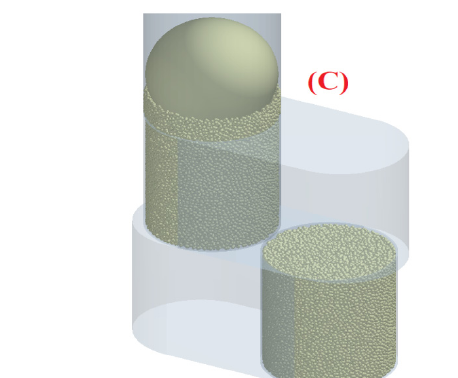
Figure 2 Shear box Simulation and assembled generation Stages particles with a 100% size ratio under 3 kPa normal